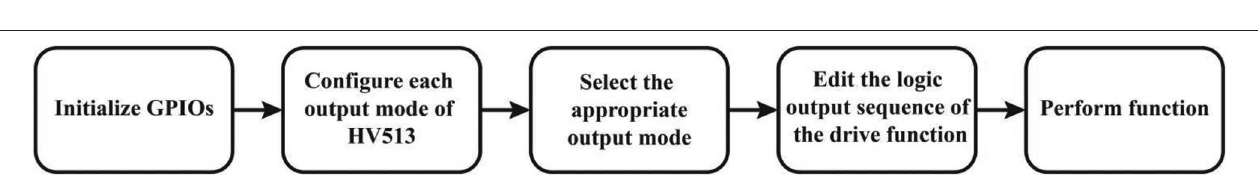
FIGURE 11 | High-voltage parallel output function